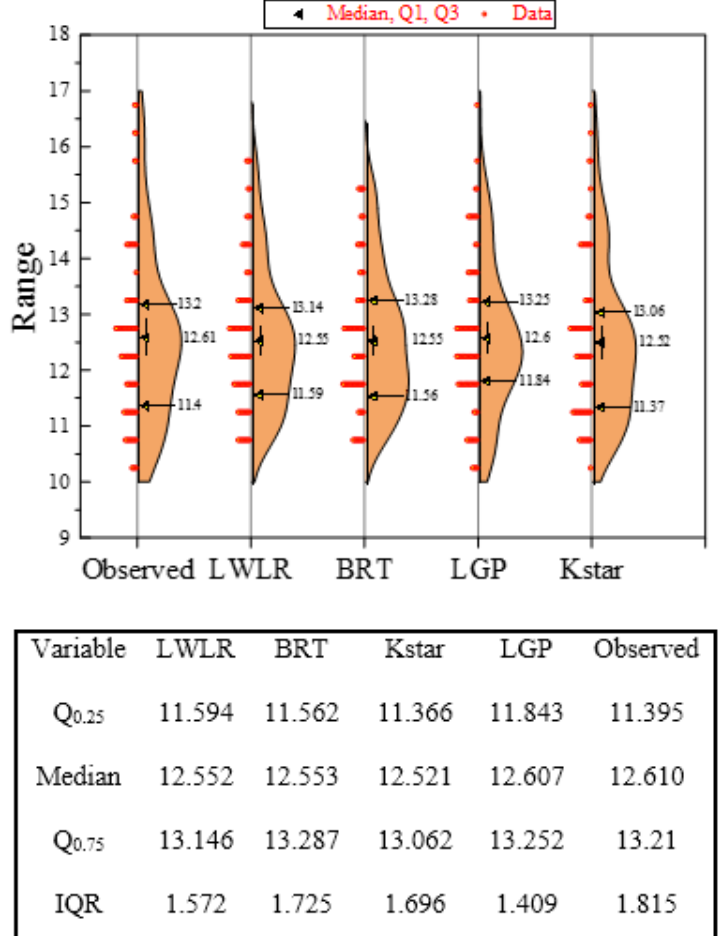
Figure 8. Performance assessment of predicted and observed BI values using half violin plots.